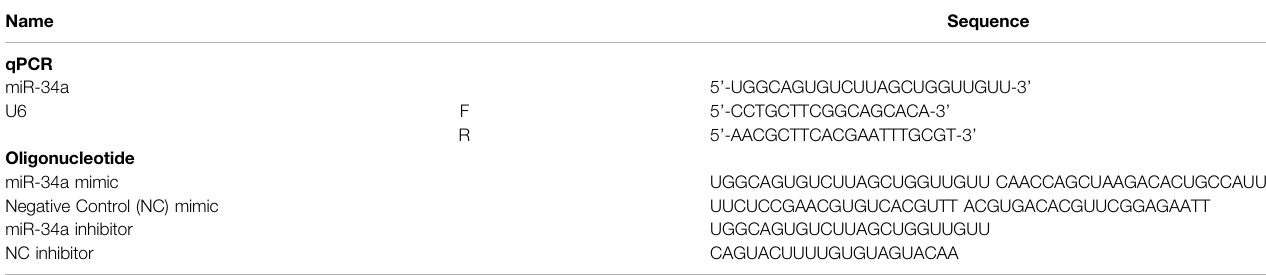
TABLE 1 | Primers for qRT-PCR and